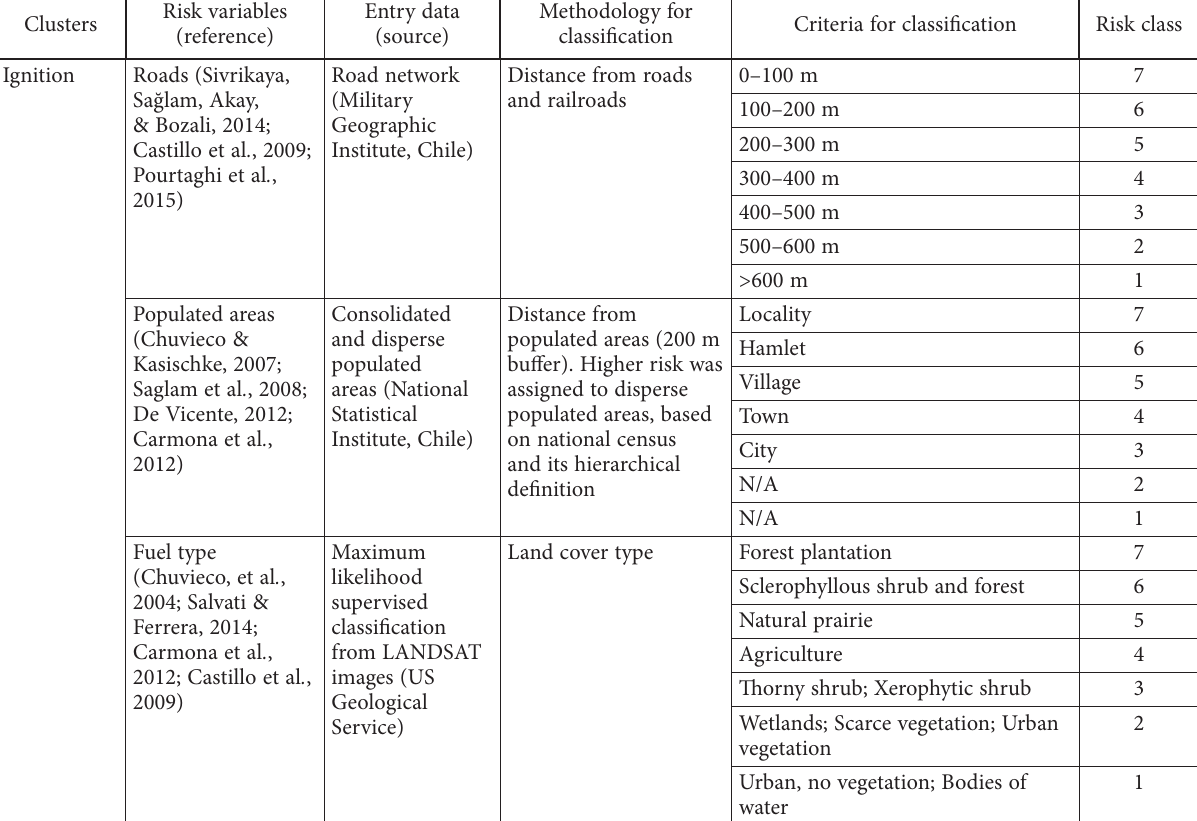
Table 1. Entry data for risk variables, defined in 30 m cells, and criteria for